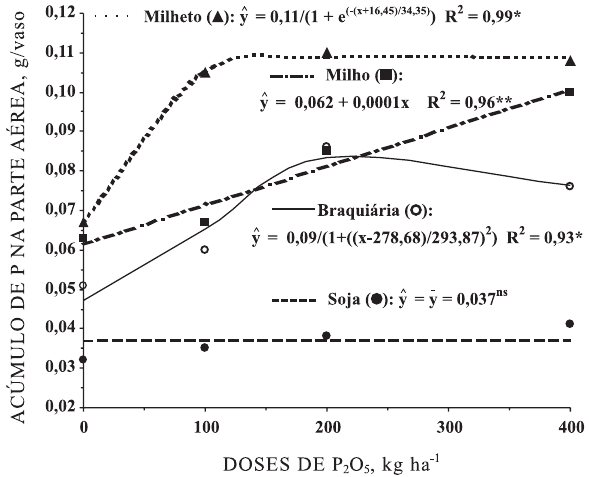
Figura 4. Acúmulo de P na fitomassa do milheto, braquiária, soja e milho aos 50 dias da emergência das plantas, em função da adubação com fosforita Alvorada. ns: não-significativo. * e ** significativos a 5 e 1 %,